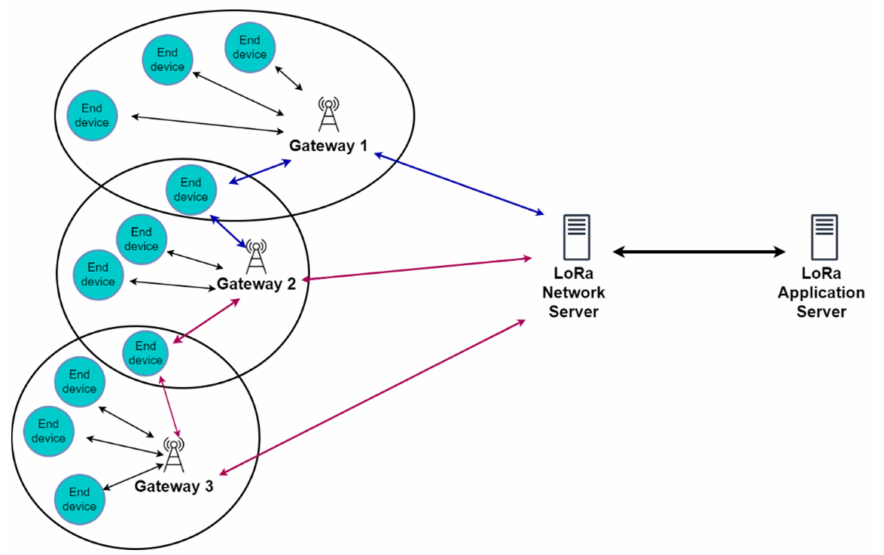
Figure 2. Star-of-stars LoRaWAN